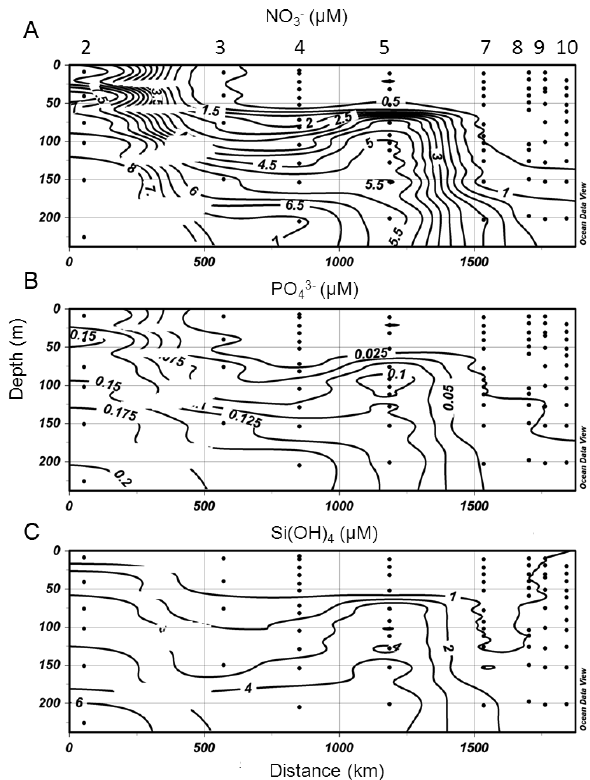
Fig. 11. Vertical distribution of (A) nitrate (NO 3 − ) , (B) phosphate Fig. 11: Vertical distribution of ( A) nitrate (NO 3- ), (B) phosphate (PO 43- ) and (C) Silicate Si(OH) 4 ) down to 200 m across the western Mediterranean Sea and the western part of the Ionian basin. ) and (C) Silicate Si(OH) 4 ) down to 200m across the west- (PO 3 − 4 ern Mediterranean Sea and the western part of the Ionian